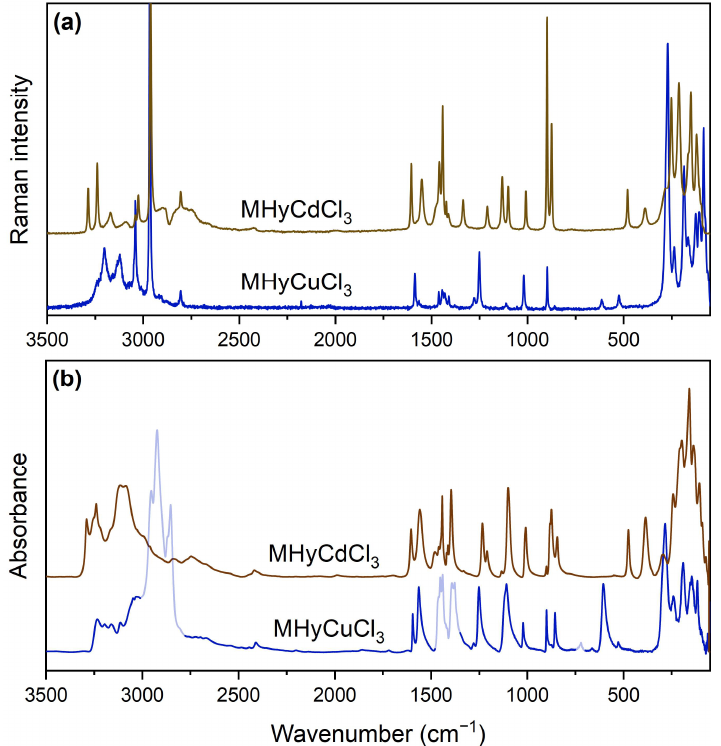
Figure 3. Raman ( a ) and IR ( b ) spectra of MHy M II Cl 3 ( M II = Cd 2+ , Cu 2+ ); transparent sections of the MHyCuCl 3 IR spectrum on panel ( b ) indicate the absorption ranges of the medium used (nujol).